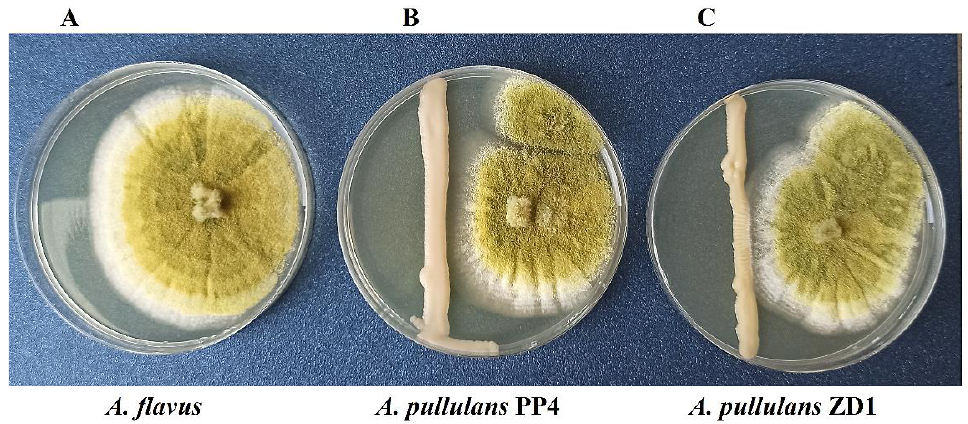
Figure 1. Growth inhibition of A. flavus caused by two yeast strains A. pullulans PP4 and A. pullulans ZD1 after 7 days of incubation at 28 °C on malt extract agar; ( A ) — A. flavus as a control; ( B ) — a dual culture of A. flavus and A. pullulans PP4; and ( C ) — a dual culture of A. flavus and A. pullulans ZD1. Table 1. In vitro effects of tested yeast on A. flavus. Inhibition (%) Yeast Mycelial Growth Spore Germination A. pullulans PP4